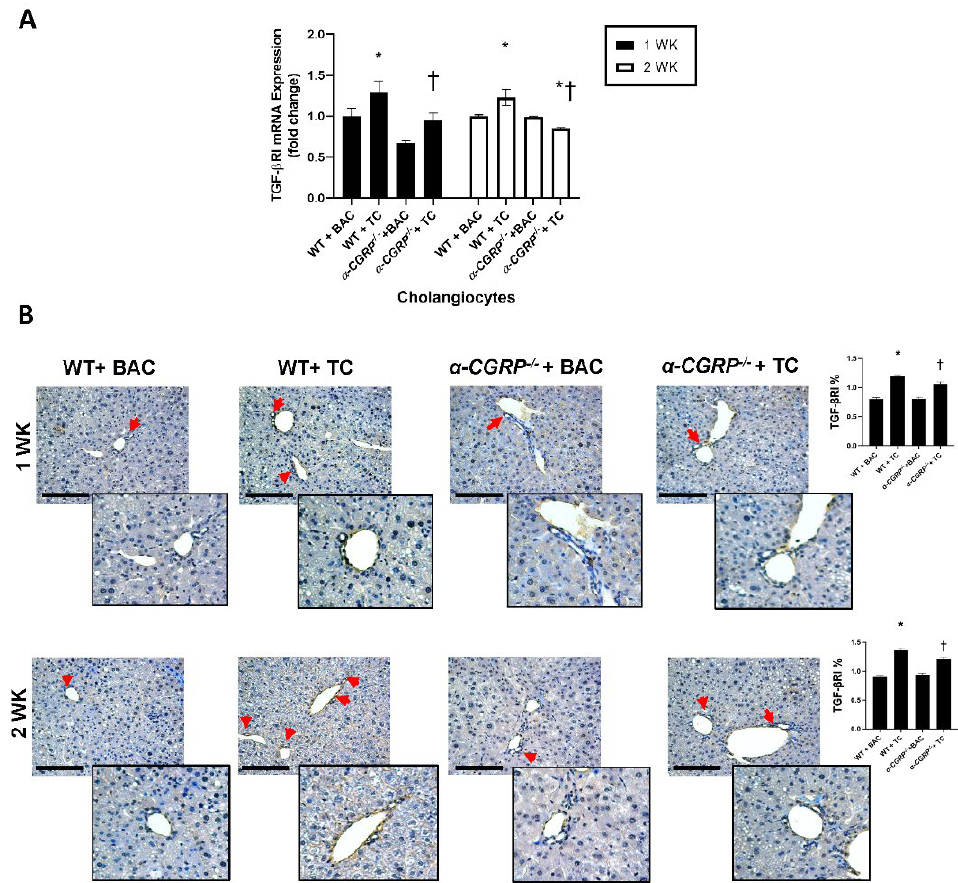
Figure 9. TGF- β RI immunoreactivity is reduced in TC-fed α -CGRP − / − mice. ( A ) mRNA expression of TGF- β RI is reduced in TC-fed α -CGRP − / − mice compared to WT fed TC in isolated cholangio- cytes. ( B ) Immunoreactivity of TGF- β RI was significantly increased in WT mice fed TC (compared to WT mice fed BAC), which was reduced in TC-fed α -CGRP − / − mice compared to WT fed TC. Original magnification 20 × . Scale Bar 100 µ m. Black box: original magnification 40 × . Data are mean ± SEM of scanning slides from n = 3 different animals per groups. Data are mean ± SEM of three evaluations from three cumulative preparations of cholangiocytes from five mice per